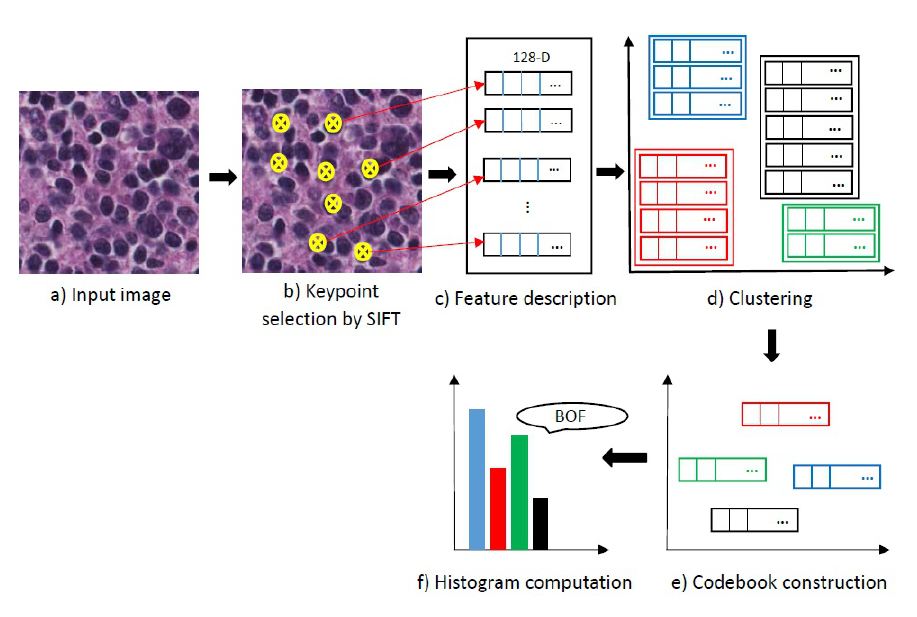
Figure 9. Scheme of the feature encoding block. Different colours indicate different clusters and different codewords. BOF, Bag of